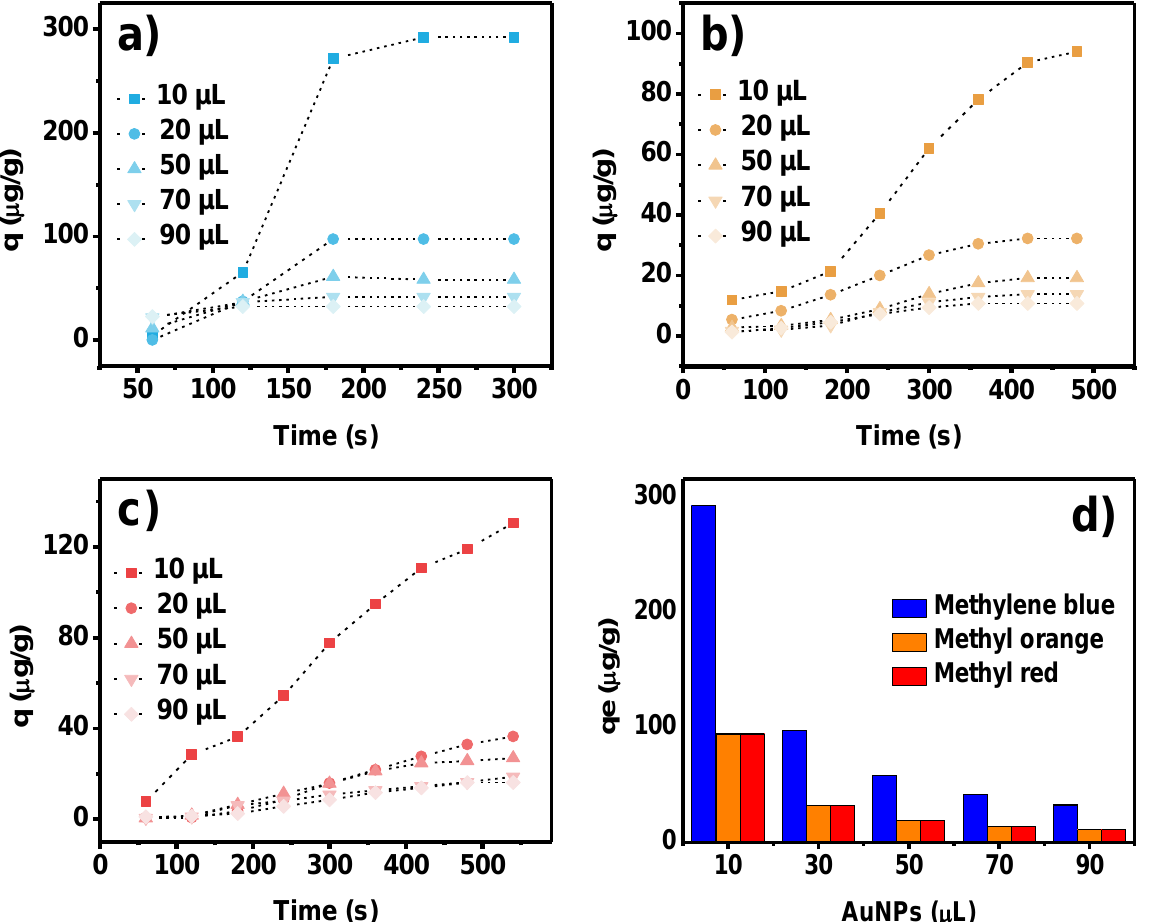
Figure 7. Time-dependent degradation capacity for ( a ) methylene blue, ( b ) methyl orange, and ( c ) methyl red at 25 °C; ( d ) equilibrium degradation capacity q e (µg∙mg −1 ) for different volumes of AuNPs used for photocatalysis.